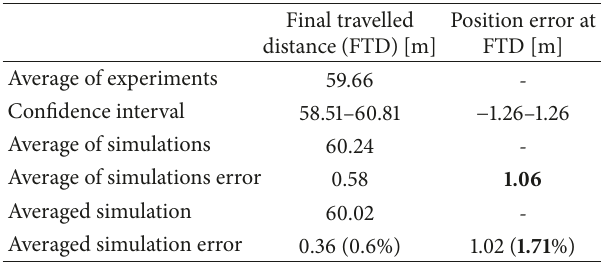
Table 12: Validation results combined